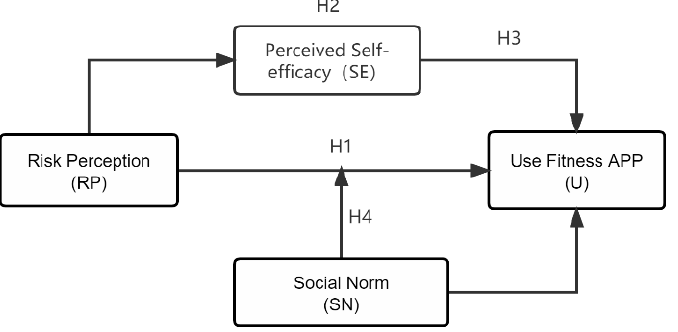
Figure 1. Conceptual Figure 1. C o nceptual Framework.